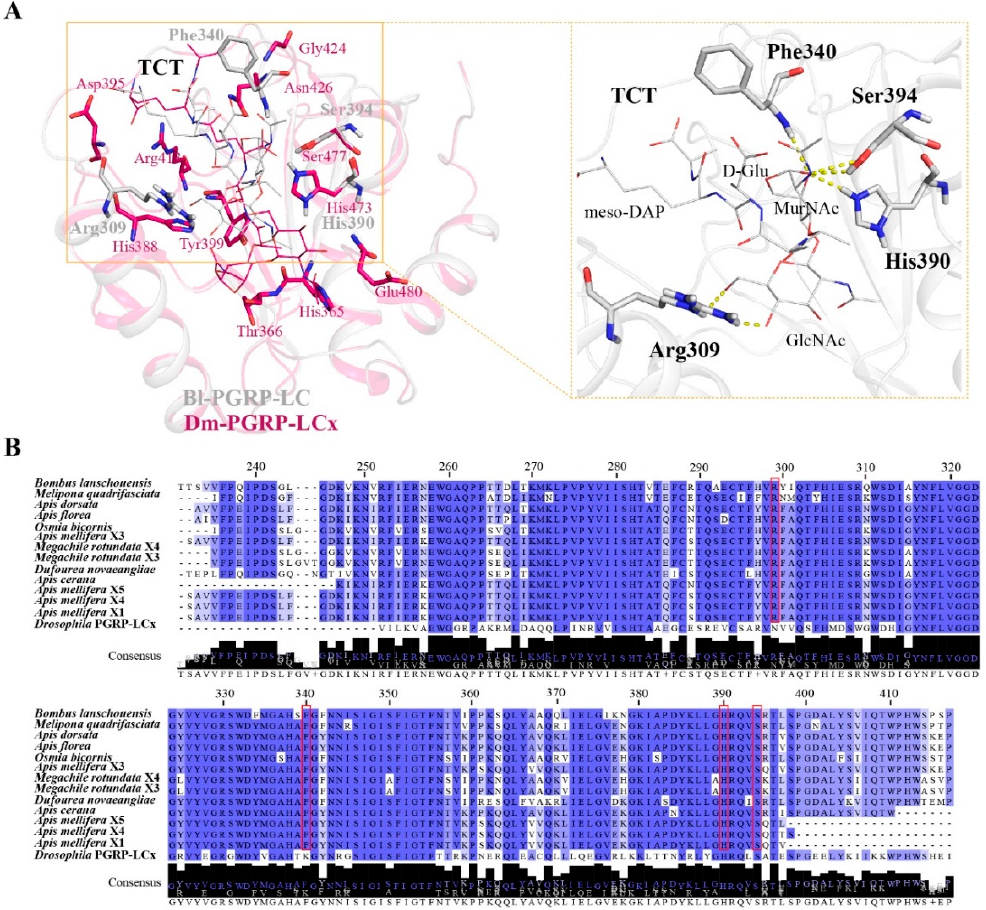
Figure 4. Analysis of the bumblebee Bl-PGRP-LC structure and the sequence alignment of PGRP-LC from bees. ( A ) Comparison of the Bl-PGRP-LC/TCT complex and the Dm-PGRP-LCx/TCT complex, colored in gray and magenta, respectively. TCT is shown as a line and the contact residues are shown as sticks. The yellow dashed line indicates the bonds between the TCT and the contact residues in the Bl-PGRP-LC/TCT structure. ( B ) Amino acid sequence alignment of PGRP-LC from different bee species ( Melipona quadrifasciata GenBank No. KOX71517.1, Apis dorsata GenBank No. XP_006618726.1 , Apis florea GenBank No. XP_003693124.1 , Osmia bicornis GenBank No. XP_029039739.1 , Apis mellifera X3 GenBank No. XP_006565566.1, Megachile rotundata X4 GenBank No. XP_003702406.2 , Megachile